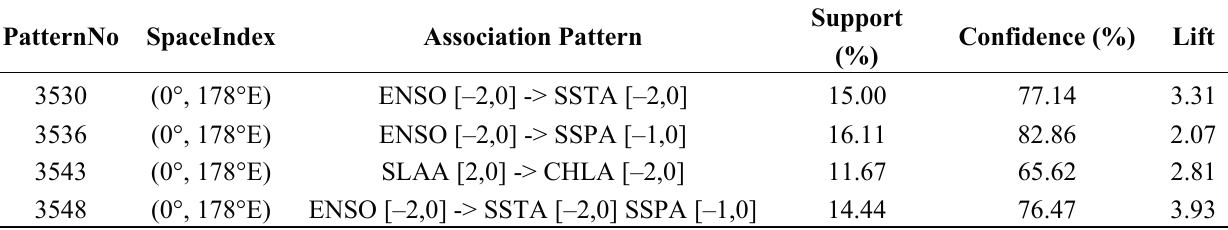
Table 2. Storage structure of association patterns about grid